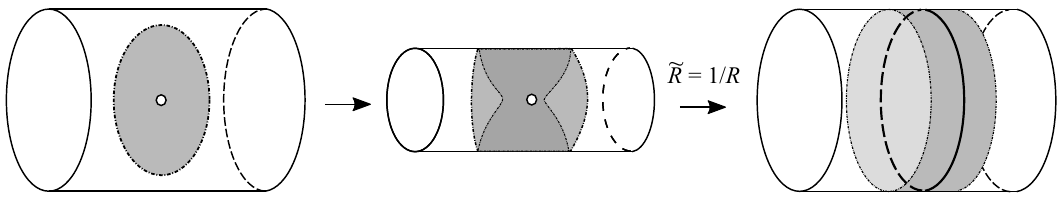
Figure 5 . T-duality relates negative D-branes of di(cid:11)erent dimensions. As the radius of the compact circle shrinks the inside of the bubble is compacti(cid:12)ed, and its T-dual can be found from (cid:12)gures 3, 4. This allows us to (cid:12)x the exotic string theory inside the bubble by relating it to the negative D0- brane, whose strong coupling limit is a smooth geometry in M-theory.